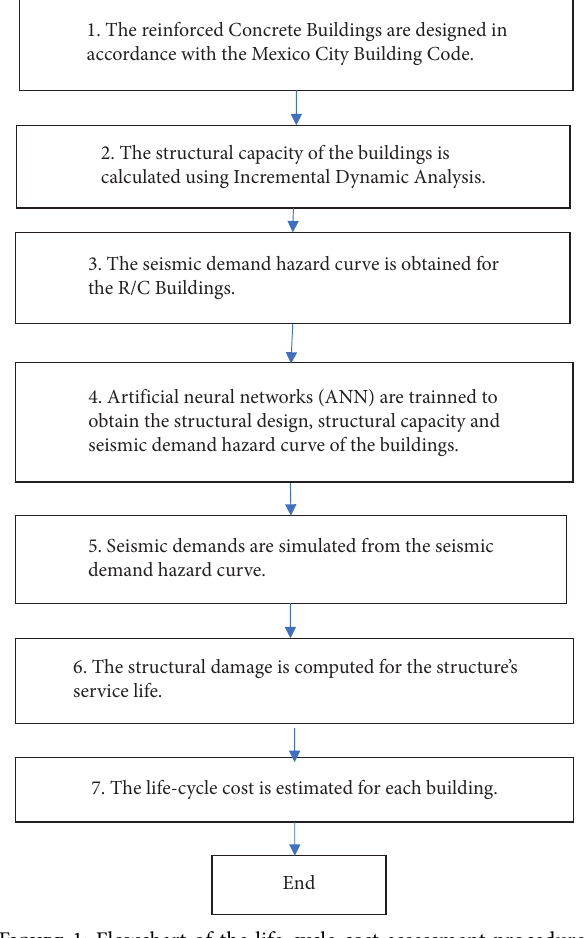
Figure 1: Flowchart of the life-cycle cost assessment